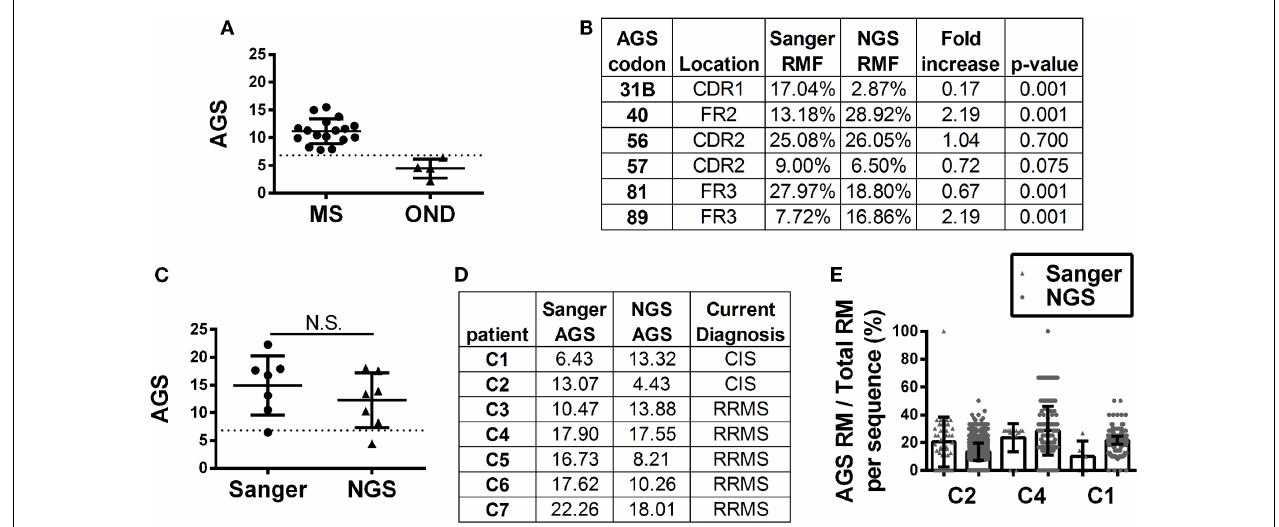
dataset. P -values were calculated by Chi-squared test. (C) Each data point represents a single patient sequence pool.The dotted line represents the AGS cut-off point of 6.8 above which patients are expected to convert to RRMS. Mean and standard deviation are shown. Statistical significance of the distributions was tested for byWilcoxon matched-pairs signed rank test (N.S. ≥ 0.05). (D) The AGS scores of the seven paired patients are shown here. (E) The percent of total RMs that belong to the AGS pattern in each sequence was mapped for three patients with different types of AGS score shifts from one platform to another.The boxes indicate mean and the error bars